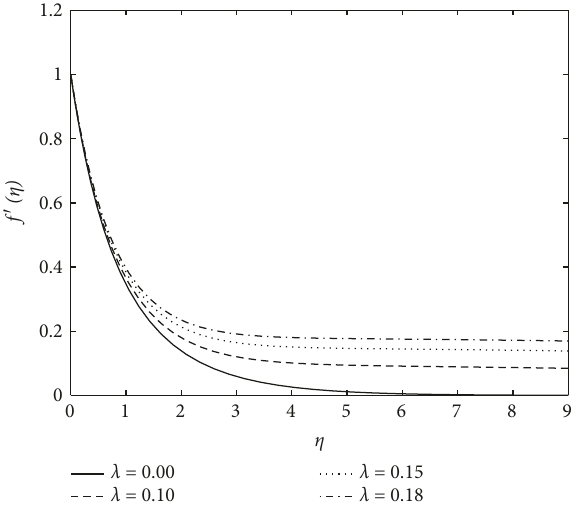
( η ) for different values of λ . ′